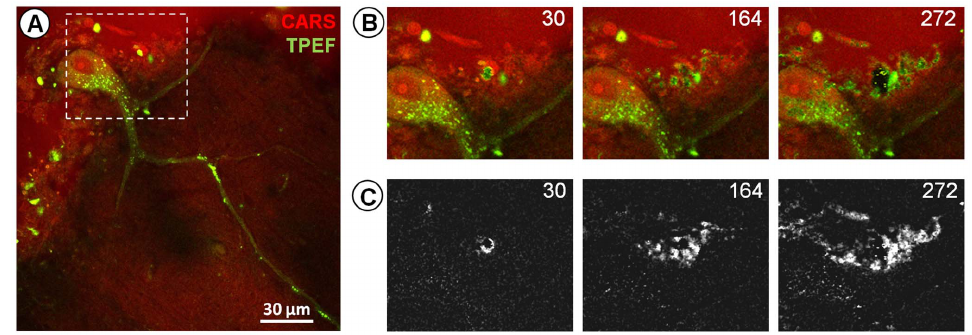
Figure 1. Effects of photodamage on ex vivo human cerebellum tissue during label-free multiphoton imaging. A : Single high quality image of a Purkinje cell acquired using CARS (red) and TPEF (green) at laser excitation power , 52 mW. B : Further serial scanning of the area indicated by the dotted-line box in A resulted in a gradual increase in TPEF. The cell body is shown after 30, 164 and 272 scans. The photodamage- induced TPEF developed first in the tissue around the cell body and then also inside the cell cytoplasm. C : TPEF difference images (corresponding to the images in B) obtained subtracting the TPEF image of the first scan from the TPEF images at 30, 164 and 272 scans respectively; they underline the photodamage-induced TPEF around the cell (see scan 164) and in the cell cytoplasm (see scan 272).